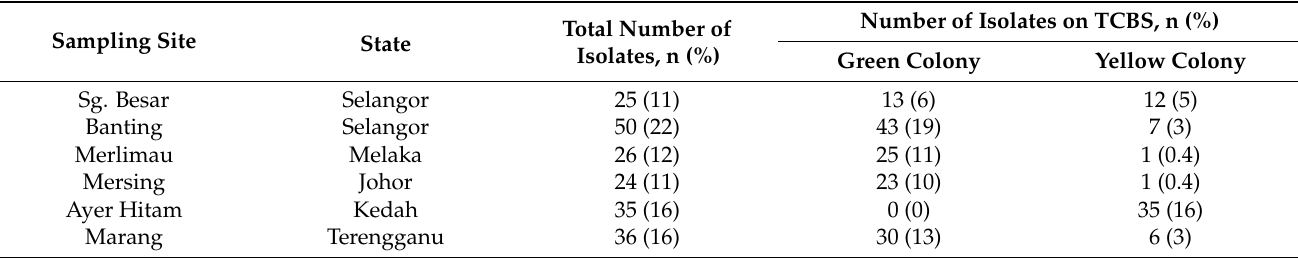
Table 2. Total number of Vibrio spp. from the cultured shrimp based on the color of the colony on